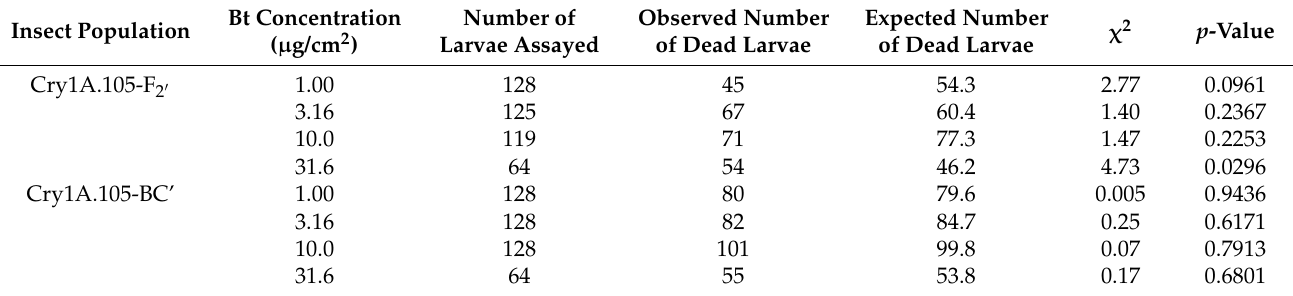
Table 4. Testing for monogenic inheritance of Cry1A.105 resistance in